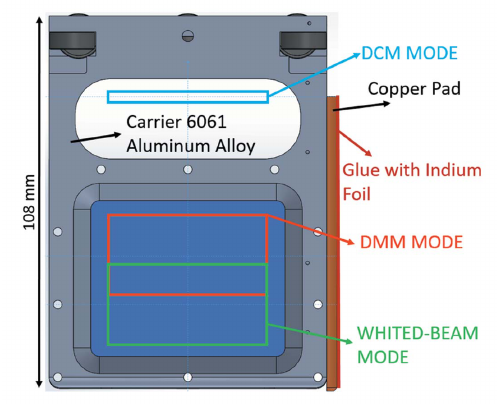
Figure 5 Diagram of the foil carrier and beam footprint of the foil carrier in different operation modes: double-crystal monochromator (DCM) mode, double-multilayer monochromator (DMM) mode, and white-beam